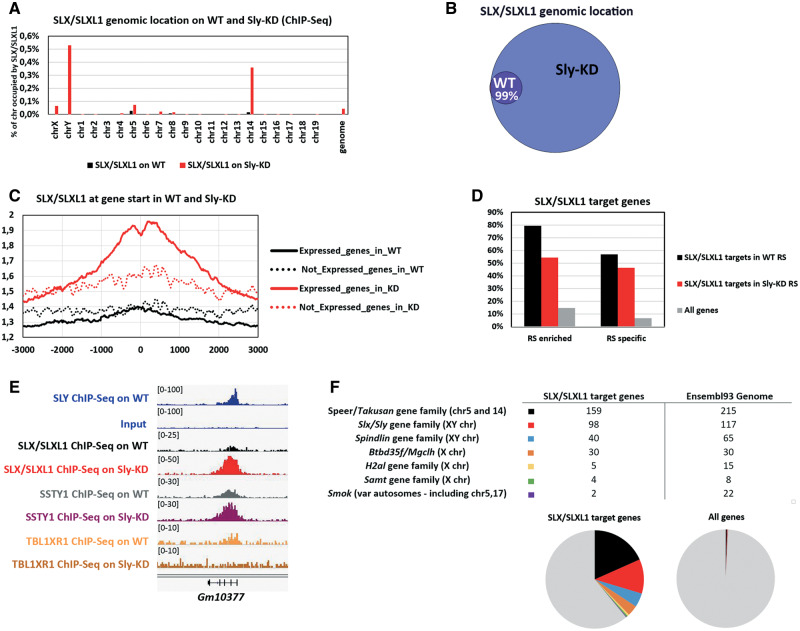

Sly knockdown leads to an increase in SLX/SLXL1 at the TSS of multicopy spermatid-expressed genes. Unless stated otherwise, the data presented in this figure represent the intersection of three independent experiments (i.e., regions found in common in the replicates); see supplementary figures S2 and S3, Supplementary Material online, for individual data. (A) SLX/SLXL1 genomic location (% of coverage of each chromosome) as identified by ChIP-Seq on WT and Sly-KD round spermatids. (B) Venn diagram showing the overlap between SLX/SLXL1 genomic targets in WT and Sly-KD round spermatids. (C) Graphic representation of SLX/SLXL1 ChIP-Seq profile in WT (black lines) and Sly-KD (red lines) round spermatids showing the average enrichment of SLX/SLXL1 around the TSS of genes expressed (unbroken lines) and not expressed (dotted lines) in round spermatids. (D) Percentage of SLX/SLXL1 target genes (TSS ± 1 kb) in WT round spermatids (black) and in Sly-KD round spermatids (red) that are enriched in round spermatids (upregulated >2× compared with pachytene spermatocytes) or specifically/de novo expressed in round spermatids (RS specific), compared with all mm10 genes (χ2, SLX/SLXL1 ChIP-Seq on WT, RS-enriched P < 0.0001; SLX/SLXL1 ChIP-Seq on WT, RS-specific P < 0.0001; SLX/SLXL1 ChIP-Seq on Sly-KD, RS-enriched P < 0.0001; SLX/SLXL1 ChIP-Seq on WT, RS-enriched P < 0.0001). (E) IGV screenshot showing SLY ChIP profile in WT round spermatids compared with its input (from Moretti et al. [2017]), SLX/SLXL1 (Exp1), SSTY1 (Exp1), and TBL1XR1 ChIP profile in WT and Sly-KD round spermatids. The genomic region shown is a portion of chromosome 14 encompassing Gm10377, a gene of Takusan family. (F) Number of SLX/SLXL1 target genes (in Sly-KD spermatids) belonging to multicopy gene families (gene copy number found using Ensembl Protein Domain ID). The pie charts underneath show the proportion of each indicated multicopy gene family compared with that of other genes (in gray) among SLX/SLXL1 target genes (left) and among all Ensembl93 mm10 genes (right).